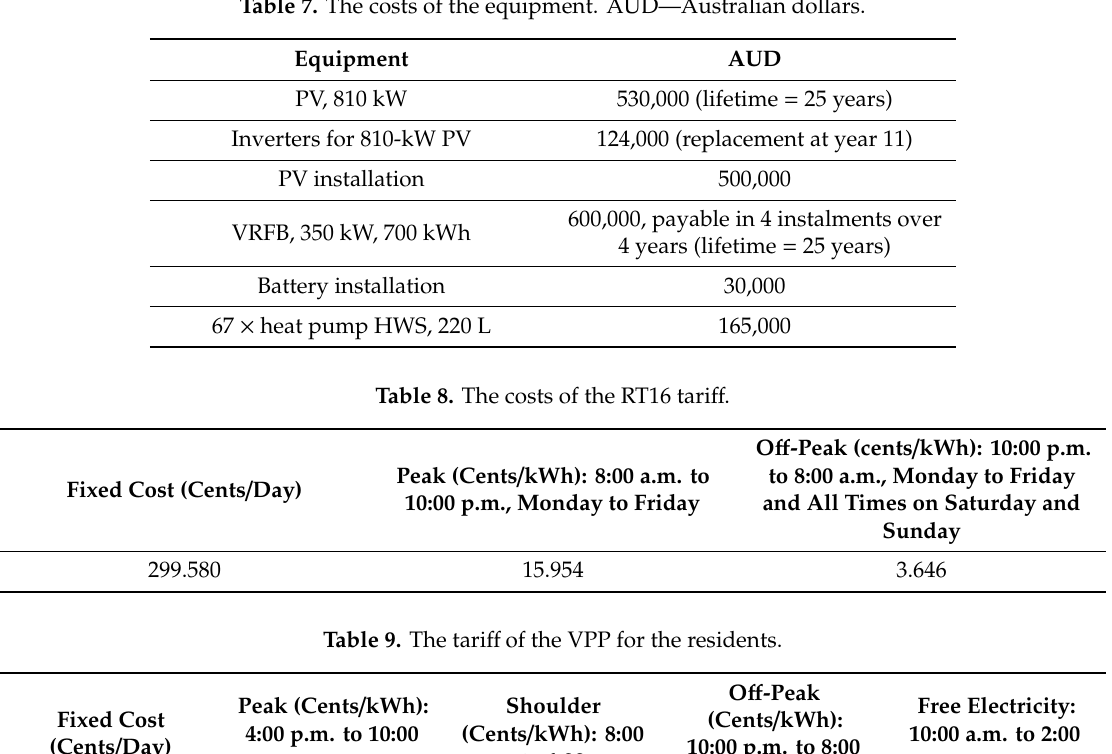
Table 7. The costs of the equipment. AUD—Australian dollars.